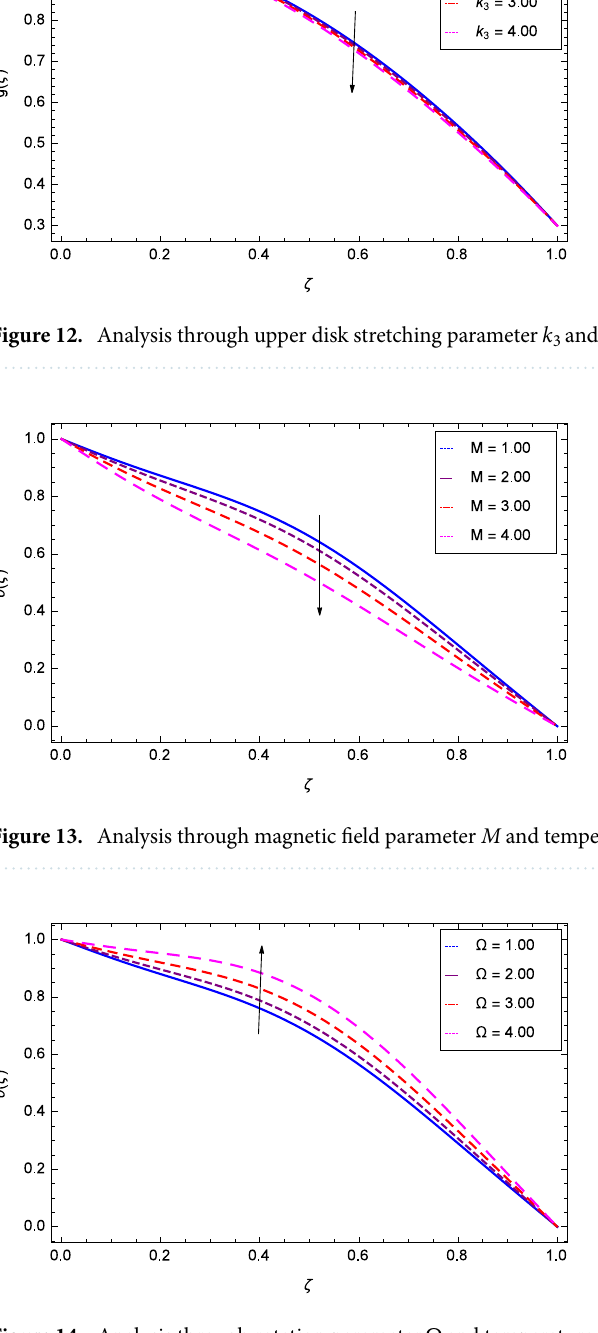
Figure 14. Analysis through rotation parameter (cid:31) and temperature θ ( ζ